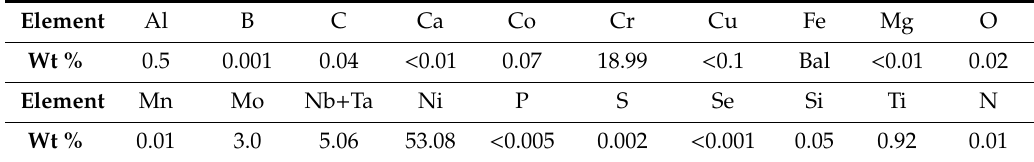
Table 1. Chemical composition of LPW IN718 powder (weight %).